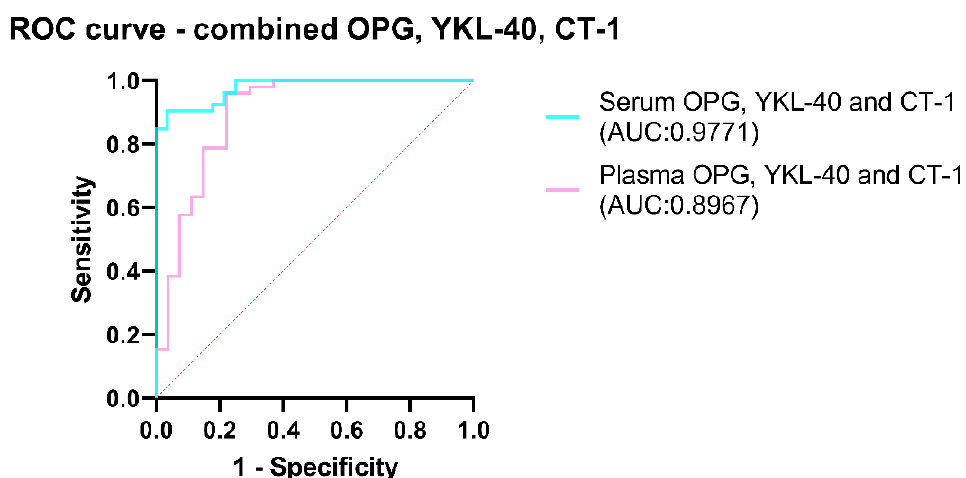
Figure 3. ROC curves of the combined concentrations of OPG, YKL-40, and CT-1 in the serum and plasma. Receiver Operator Characteristic curve analysis is calculated for all subjects in classifying for OSA and non-OSA groups. Abbreviations: OSA, Obstructive Sleep Apnea; OPG, Osteoprotegerin; YKL-40, Chitinase-3 like protein-1; CT-1, Cardiotrophin-1; AHI, Apnea–Hypopnea Index; ROC, Receiver Operator Characteristic; AUC, Area Under the Curve. Table 4. Multiple linear regression estimates using sex, AHI, age, and BMI as independent variables.